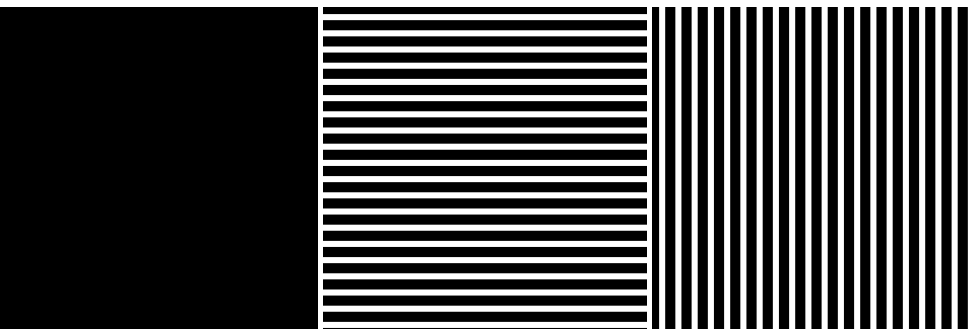
Figure 6. Graphical demonstration showing importance of complex spatial patterns in different images with the same number of pixels. We compute mean absolute difference between source A ( left ) and each of the targets B ( center ) and C ( right ). Targets B and C have the same number of white pixels, which results in the same value of mean absolute difference. Complex spatial patterns can be captured by considering rows or columns of an image as spatial